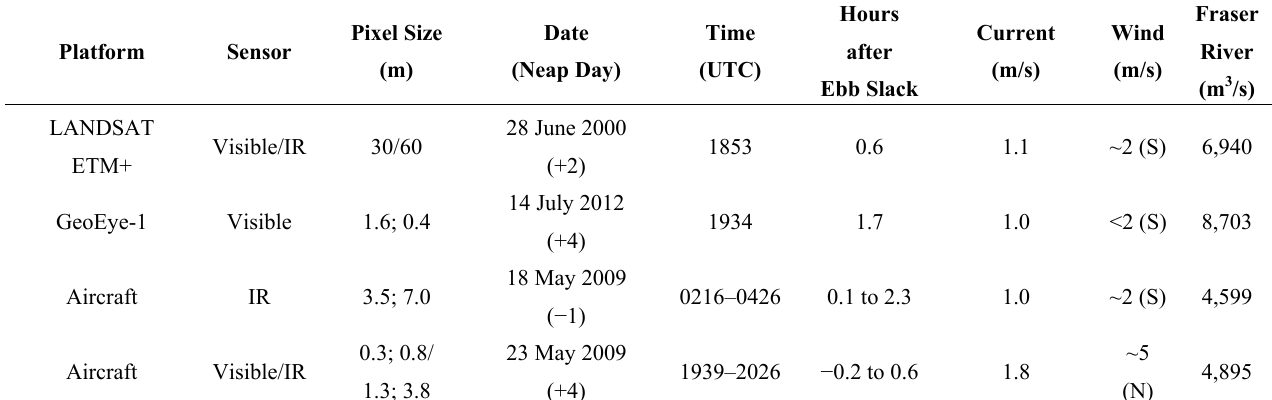
Table 1. Imagery sources and conditions. The number of days since neap tide is shown in parentheses after the date. Hours after ebb slack fall largely within the expected ‘strong forcing’ range of 0.5 to 1.5 h. The current is the predicted speed at maximum flood tide in Boundary Pass. Wind speed (direction) values measured at East Sound, Orcas Island. Right-most column shows weekly Fraser River discharge rates measured at Hope, BC,